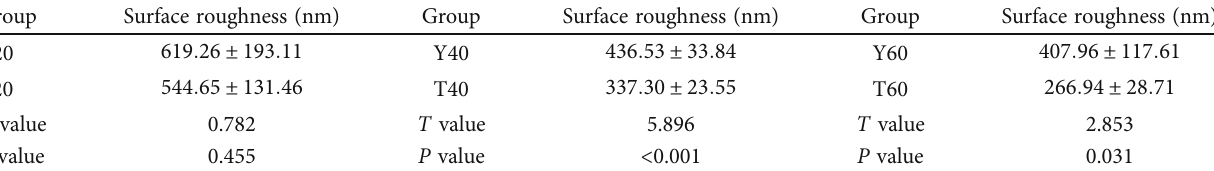
Table 3: Comparison between the same subgroups in Y group and T group.